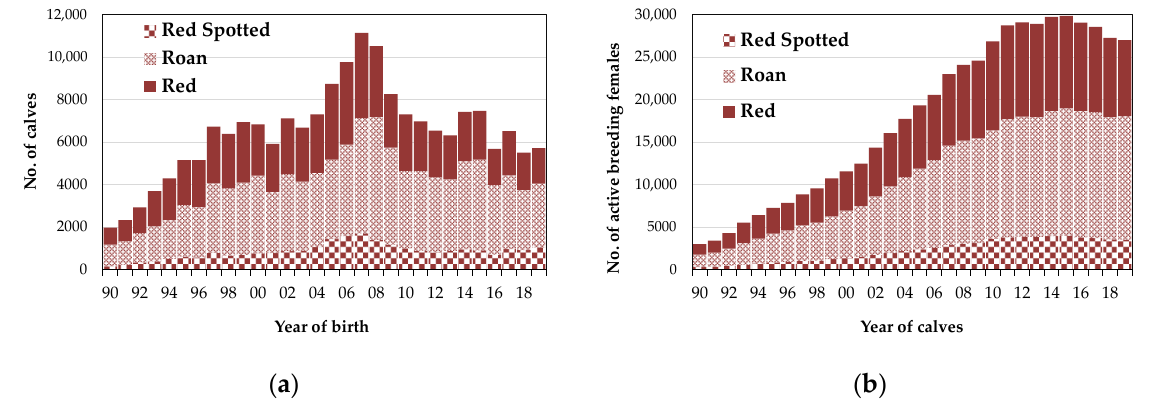
Figure 3. Number of animals registered in the Mertolenga’s Herdbook by year and coat variety. ( a ) Calves, ( b ) breeding females.